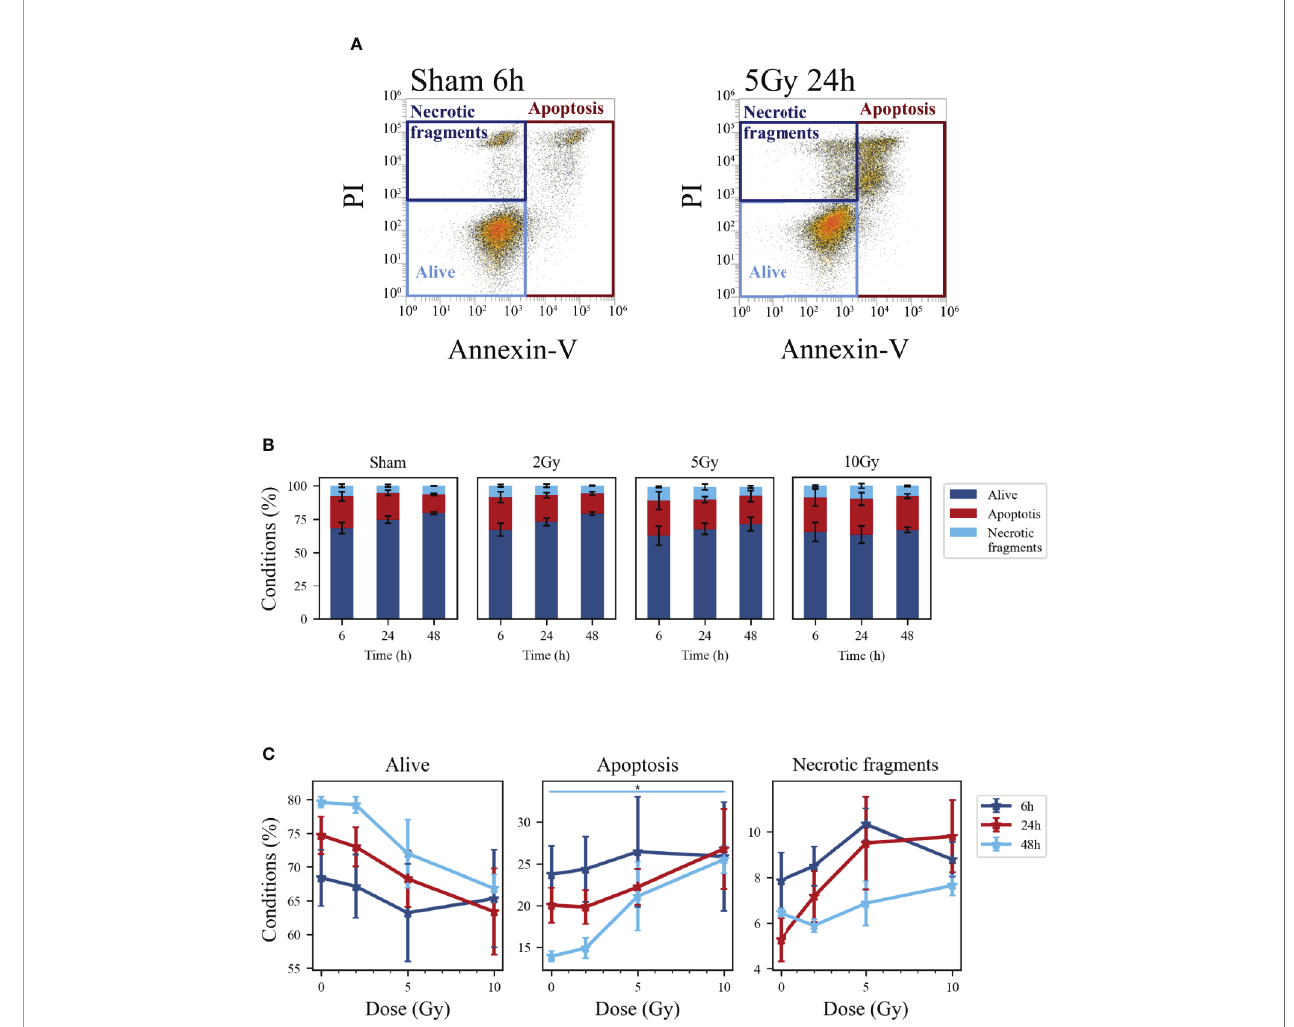
FIGURE 6 | Cell death analysis with fl ow cytometry following the “ Seed + Treat ” protocol. (A) Gating strategy to identify in the Caco-2 population living cells (Alive), apoptotic cells (Apoptosis) and any intermediate cell death form (Necrotic fragments) in the biparametric plot of Annexin V vs. PI signals, demonstrated with illustrative data for: sham condition at 6 h (left); 5-Gy-irradiated cells at 24 h (right). (B) Percentages of living, apoptotic cells and necrotic fragments for the different irradiation conditions as a function of time. (C) Percentages of living, apoptotic cells and necrotic fragments for the different time points as a function of X-ray dose (same data as in panel B, lines are a guide to the eye). Data are mean ± SEM, obtained from ≥ 3 independent experiments. Statistical signi fi cance (post-hoc pairwise comparisons with Bonferroni correction) is as follows: *p <